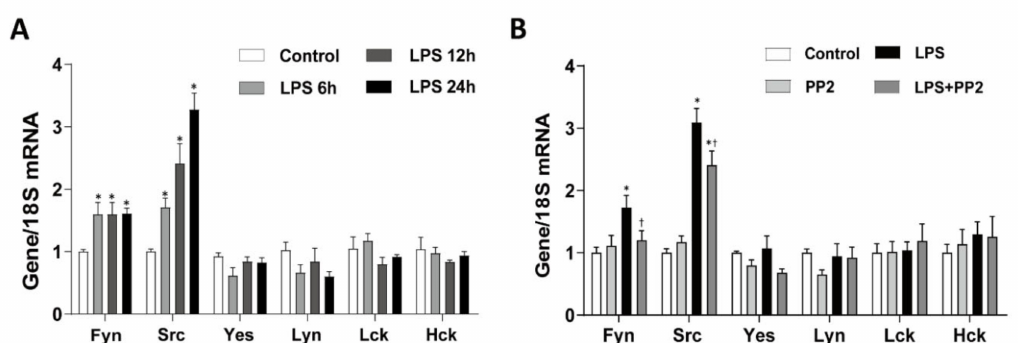
Figure 5. LPS increases Src family kinases (SFK) mRNA expression in AKI mice. ( A ) Six-week-old male C57 / BL6 mice were treated with LPS (15 mg / kg) in a time-dependent manner (0, 6, 12, and 24 h). ( B ) Six-week-old male C57 / BL6 mice were pretreated with PP2 (2 mg / kg) for 2 h and then administered LPS (15 mg / kg) for 18 h. ( A , B ) The levels of SFK mRNA expression were measured using real-time RT-PCR analysis. Levels of mRNA were normalized with 18S. Data are presented as mean ± SE of 6–8 mice. * p < 0.05 vs. control, † p < 0.05 vs.